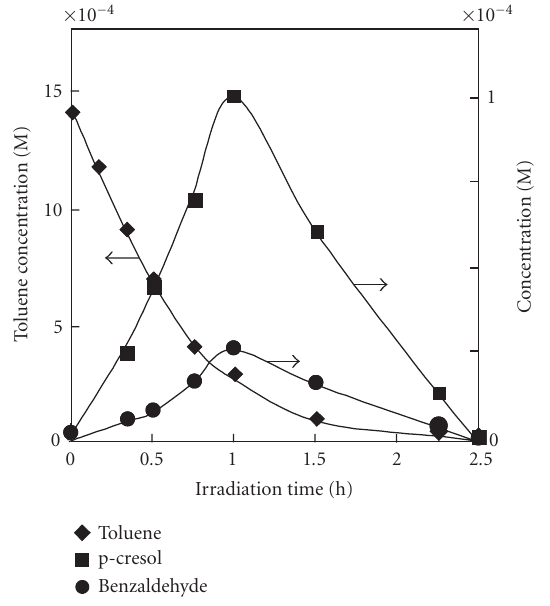
Figure 5: Toluene ( (cid:3) ), p -cresol ( (cid:2) ), and benzaldehyde ( ) concen- trations versus irradiation time for a run carried out by using TiO 2 Degussa